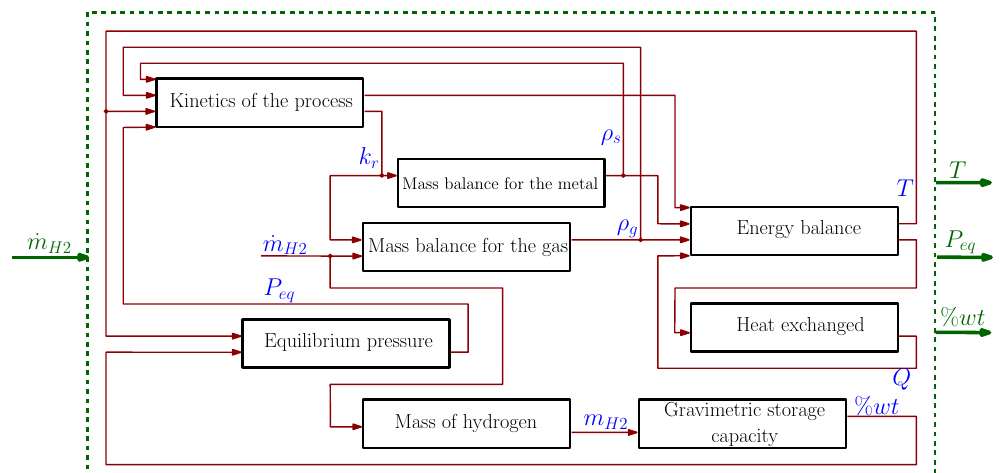
Figure 2. Derivation of the dynamic tank model from the equations in the Table 1.